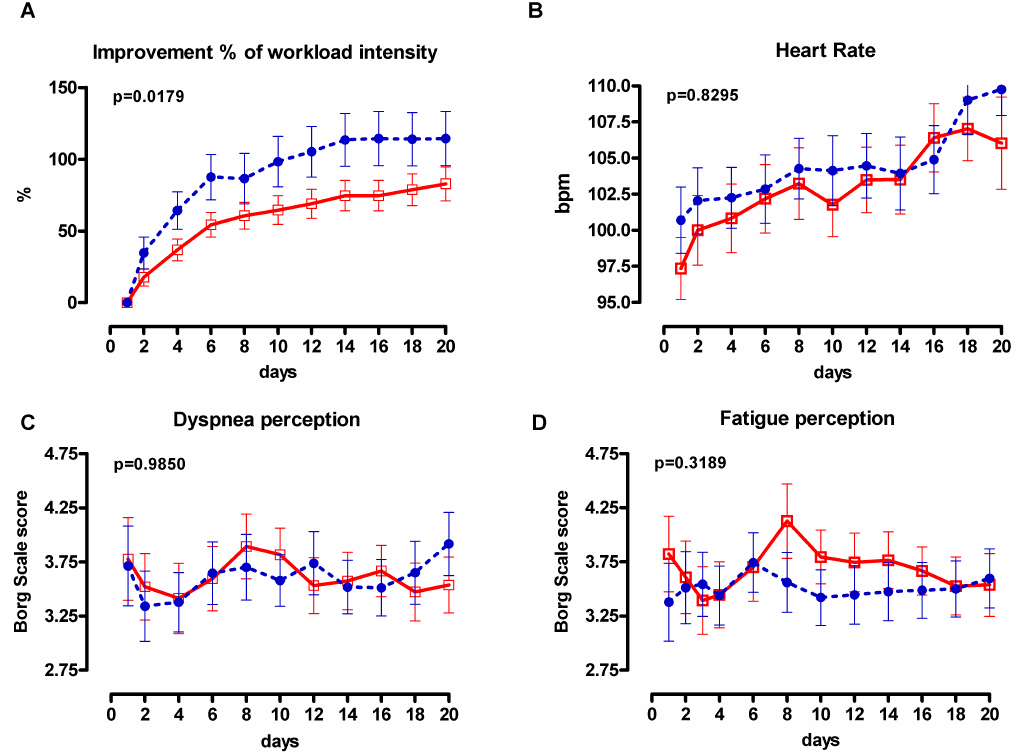
Figure 4. A : Day by day workload (expressed percentage improvement from the initial training session), B : heart rate and C / D symptoms during training. Closed circles = twice daily (G2); open squares = once daily (G1). The values for G2 are the average of maximum values over the two daily training sessions. Error bars indicate standard error (SE) of the mean. P refers to the ANOVA time group factor.